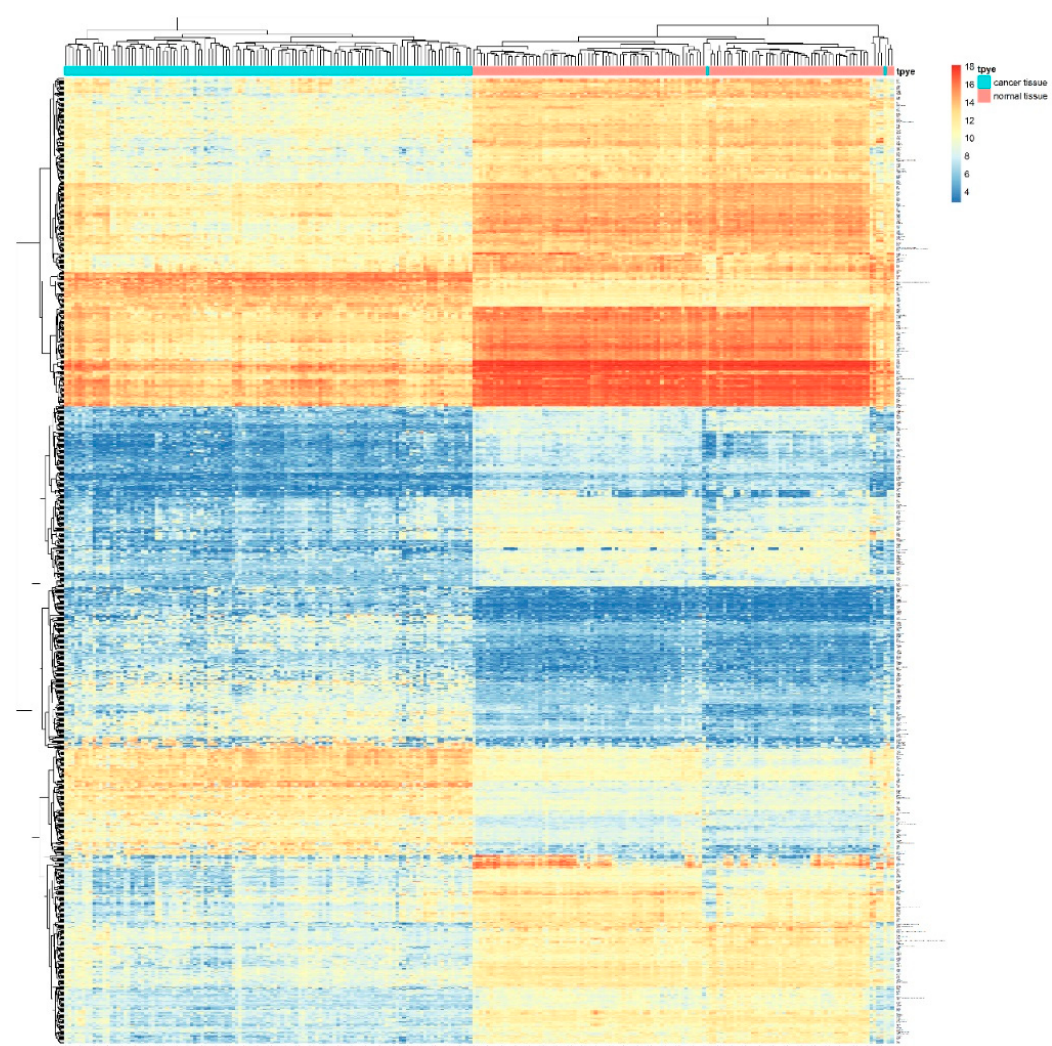
Figure 2. Heatmap of differential gene expression in each cancer tissue (blue band at the top) and normal tissue (red band at the top). Each square represents each gene, and each colored square in the heatmap represents the expression level of the gene. The higher the expression level, the darker the color will be (red represents highly expressed, blue means low expression value). Each row represents the expression level of each gene in different samples, and each column represents the expression level of all genes in each sample.